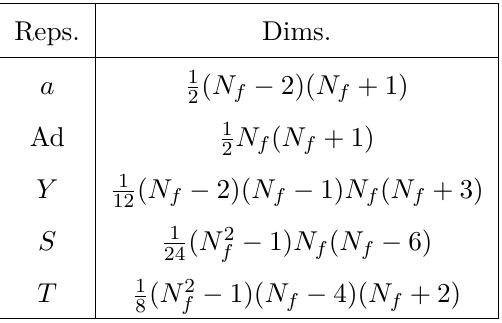
Table 3 . Representations in USp( N f ) and their